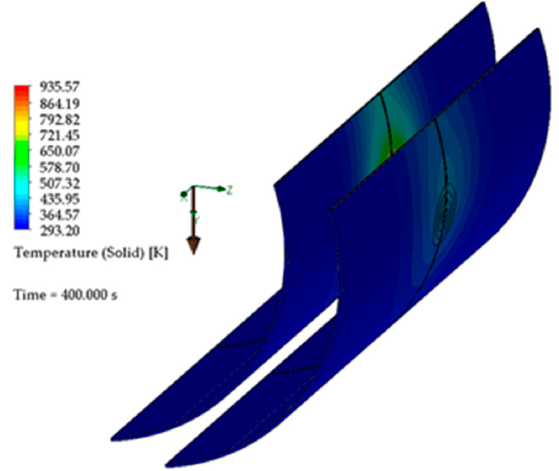
Figure 17. Temperature at 400 s.